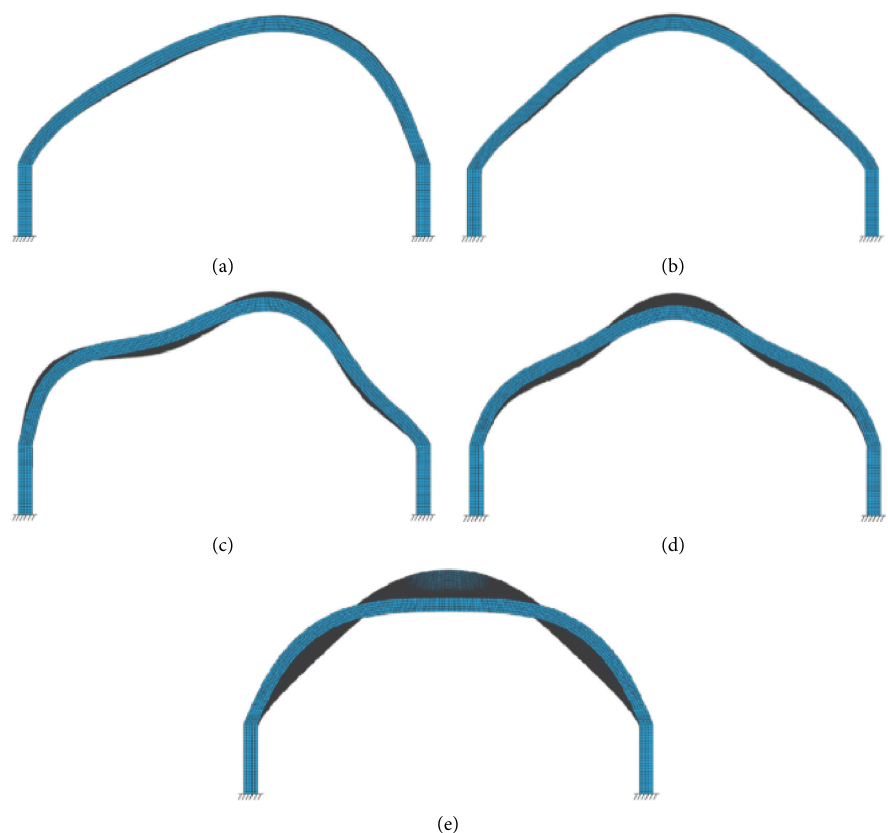
Figure 8: The first five orders of modal shapes for the arch with rigid support. (a) ω 1. (b) ω 2. (c) ω 3. (d) ω 4. (e) ω